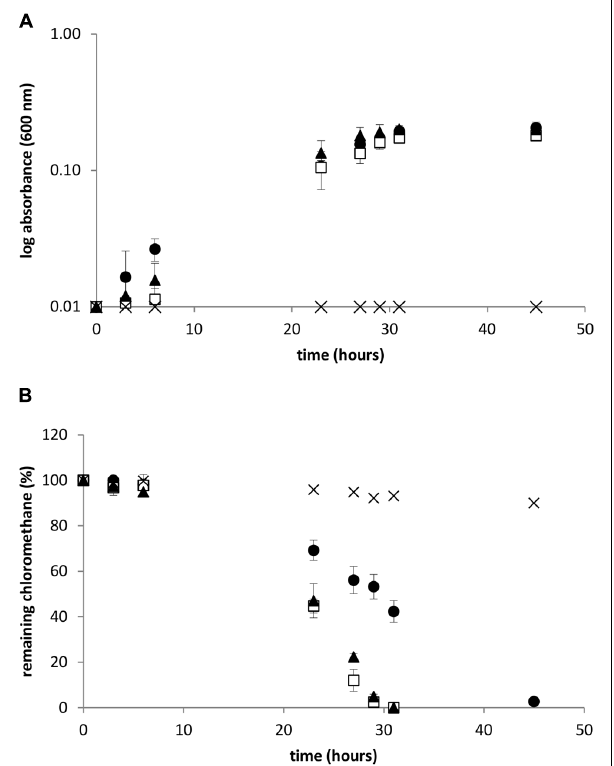
FIGURE 2 | Growth and chloromethane degradation during bacterial cultivation . Absorbance at 600 nm (A) and consumption of chloromethane (B). Leisingera methylohalidivorans MB2 (•), M. extorquens CM4 ( (cid:2) ) Hyphomicrobium sp. MC1 ( (cid:3) ) and abiotic control ( × ). Error bars indicate the standard deviation of the mean of three biological replicates. Chloride concentration at the end of cultivation were 9.2 ± 0.2 and 9.2 ± 0.3 mol L − 1 for strains CM4 and MC1, respectively, but could not be measured in the high-salt medium used for growth of strains